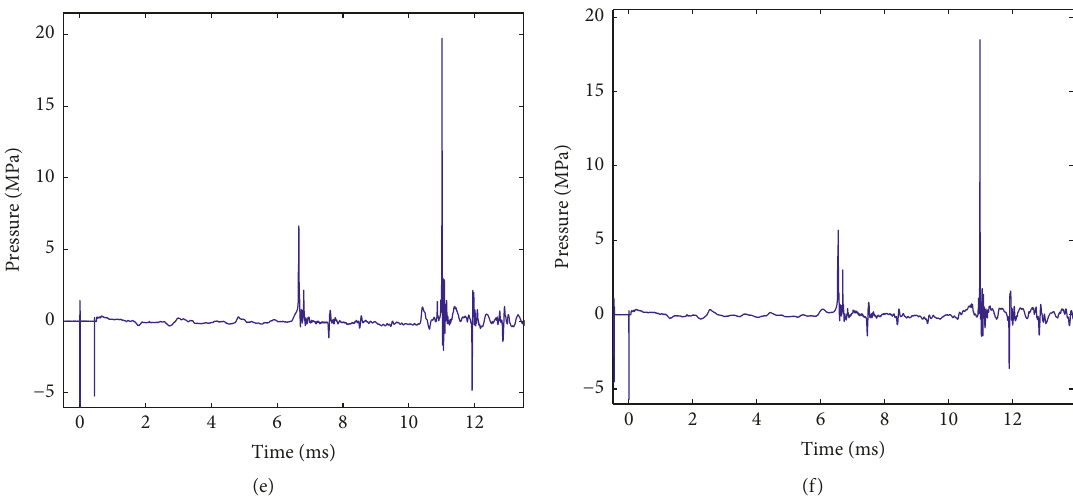
Figure 15: Pressure-time profile recorded by HPB with a (a) 35 mm, (b) 40mm, (c) 45mm, (d) 50mm, (e) 55 mm, and (f) 60mm standoff.